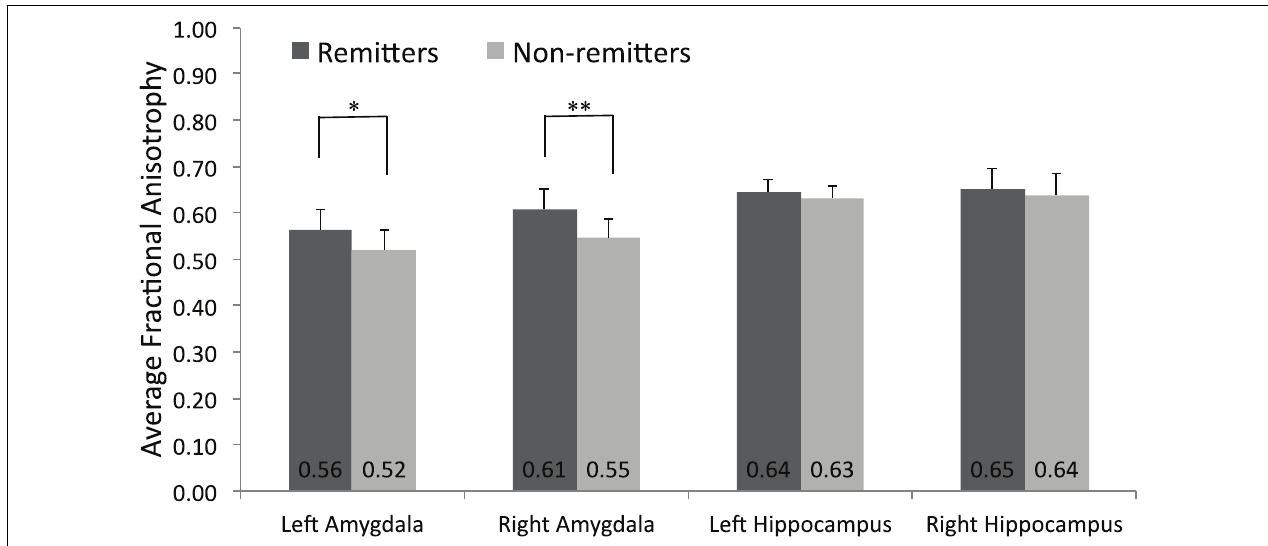
FIGURE 2 | Mean fractional anisotropy values in the amygdala and hippocampus. DW-MRI images of were acquired of 18 depressed subjects prior to SSRI treatment.The mean and standard deviation of those who remitted to treatment ( n = 8) and those who did not ( n = 10) is plotted.* p = 0.06, ** p = 0.007.